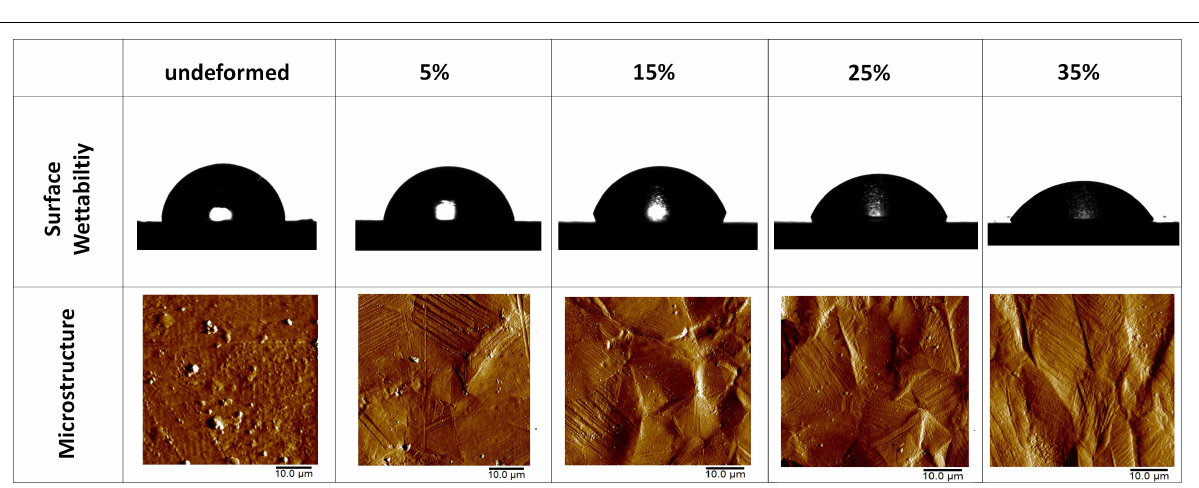
FIGURE 4 | Photographs of the water droplets on the undeformed and deformed samples represent the wettability of the samples. AFM amplitude images of the undeformed and deformed samples show the influence of plastic deformation on the microstructure. (Figure is more readable and visible on the screen rather than in